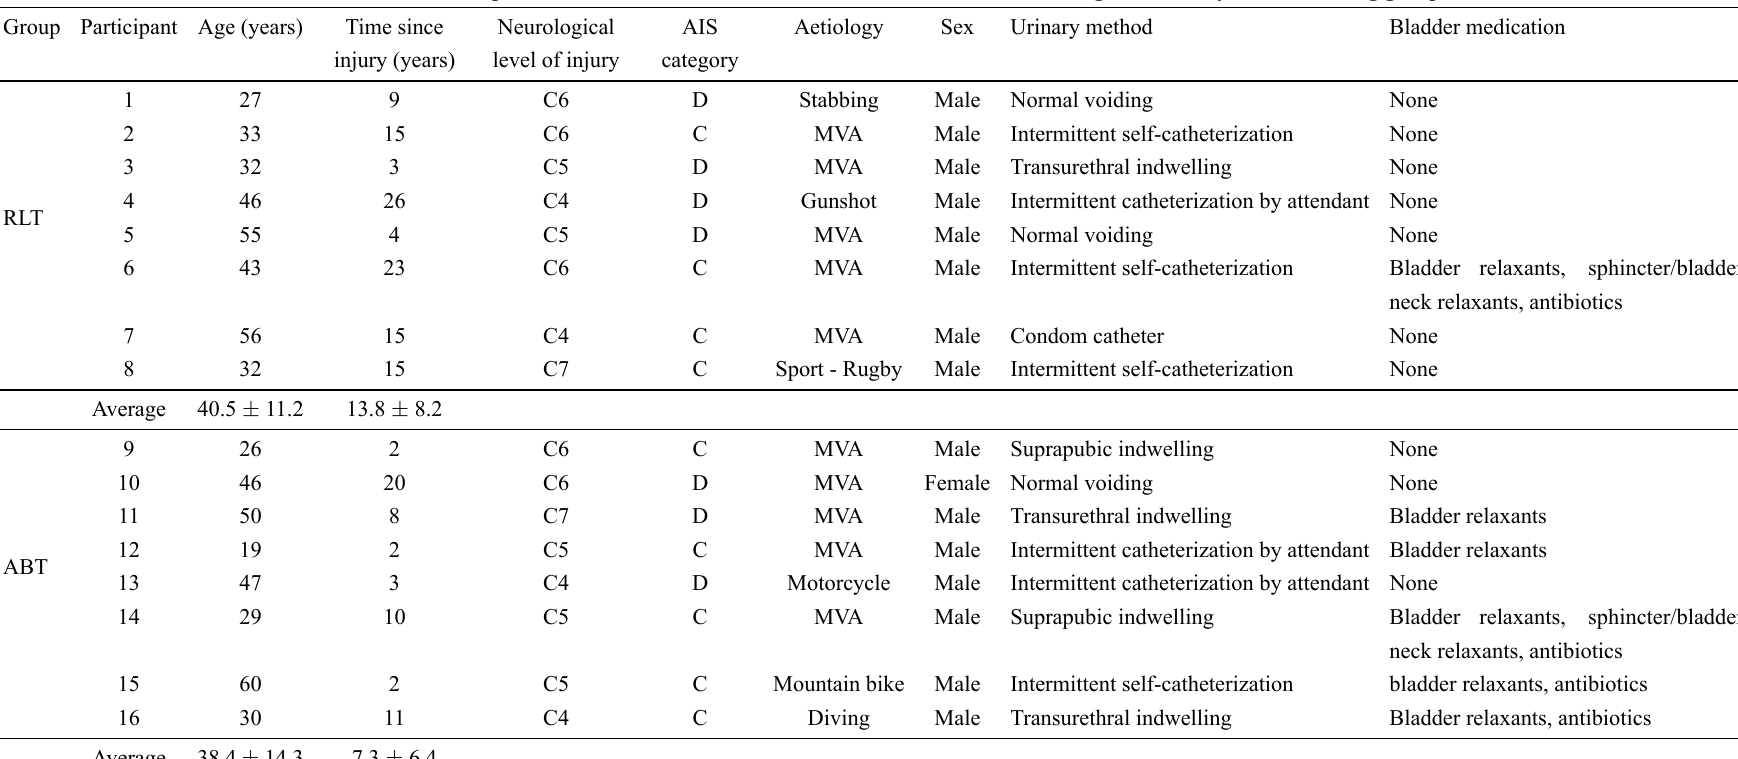
Table 1. Baseline descriptive bladder characteristics of the Robotic Locomotor Training and Activity-based Training